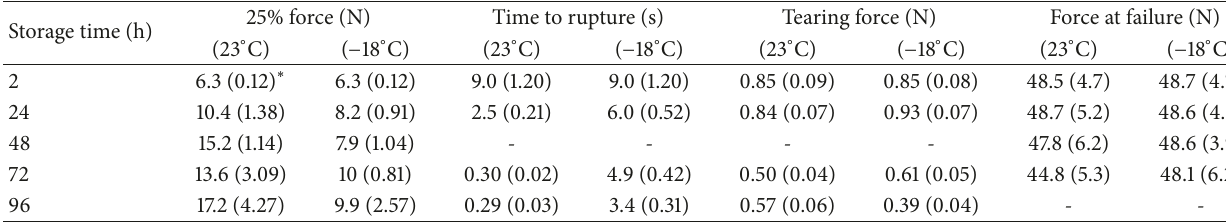
Table 2: Various textural properties of